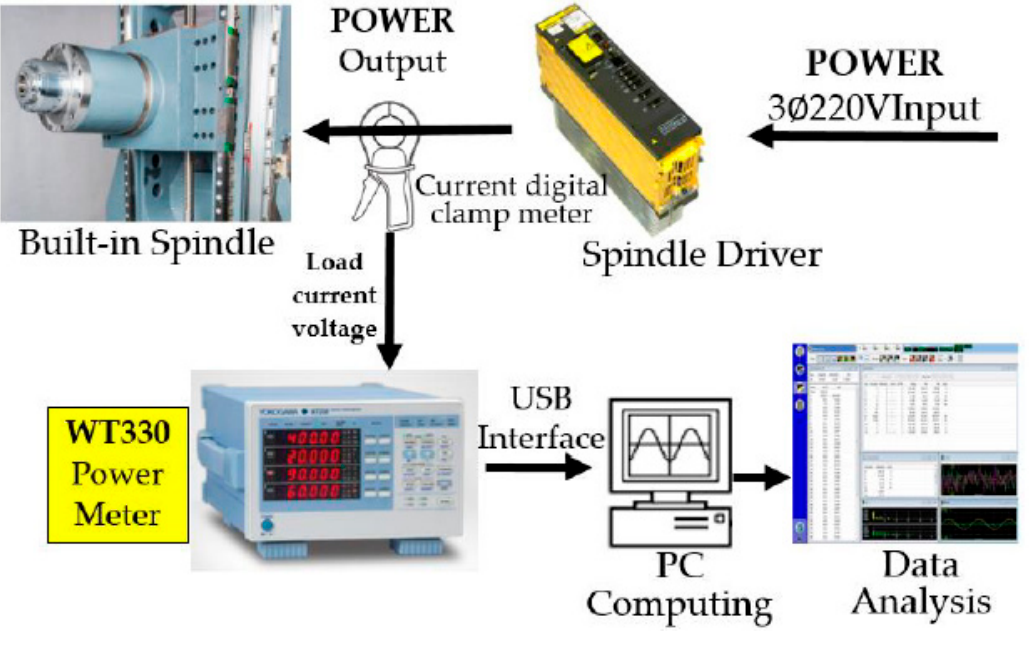
Figure 5. Spindle power measurement process.